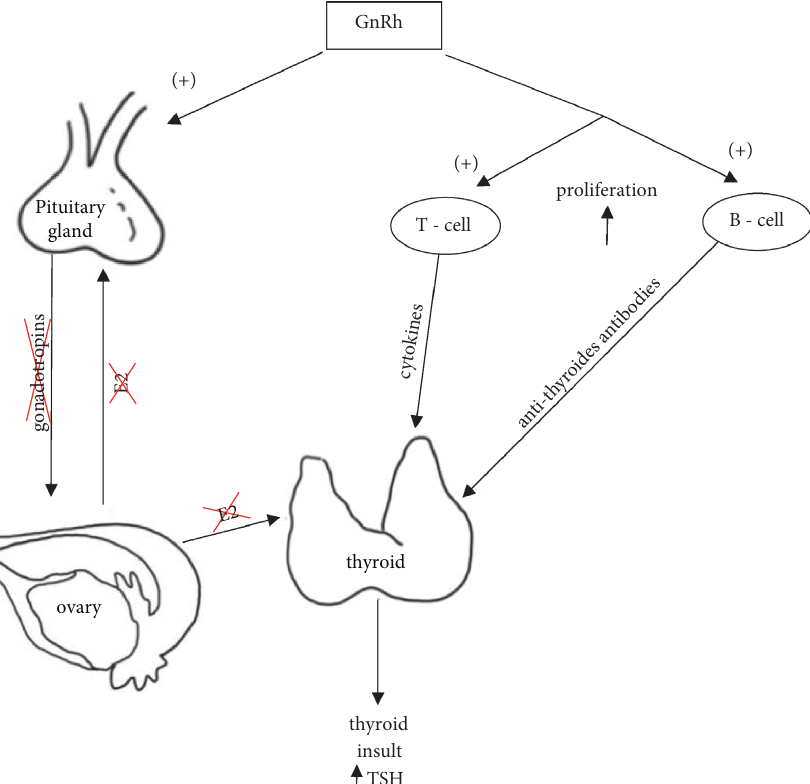
Figure 3: Different mechanisms of action of GnRH on thyroid. GnRH can stimulate receptors on T and B lymphocytes with release of cytokines and thyroid antibodies that act negatively on the